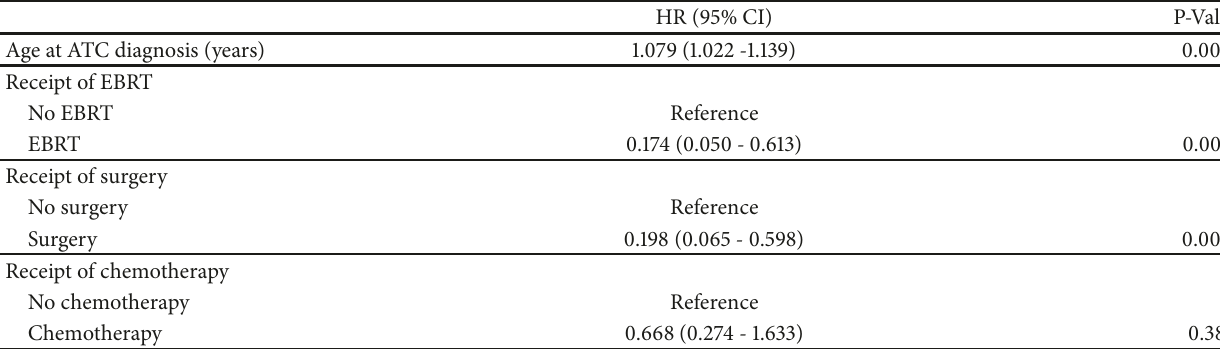
Table 4: Multivariate overall survival analysis (N=28, # events=26, 7%